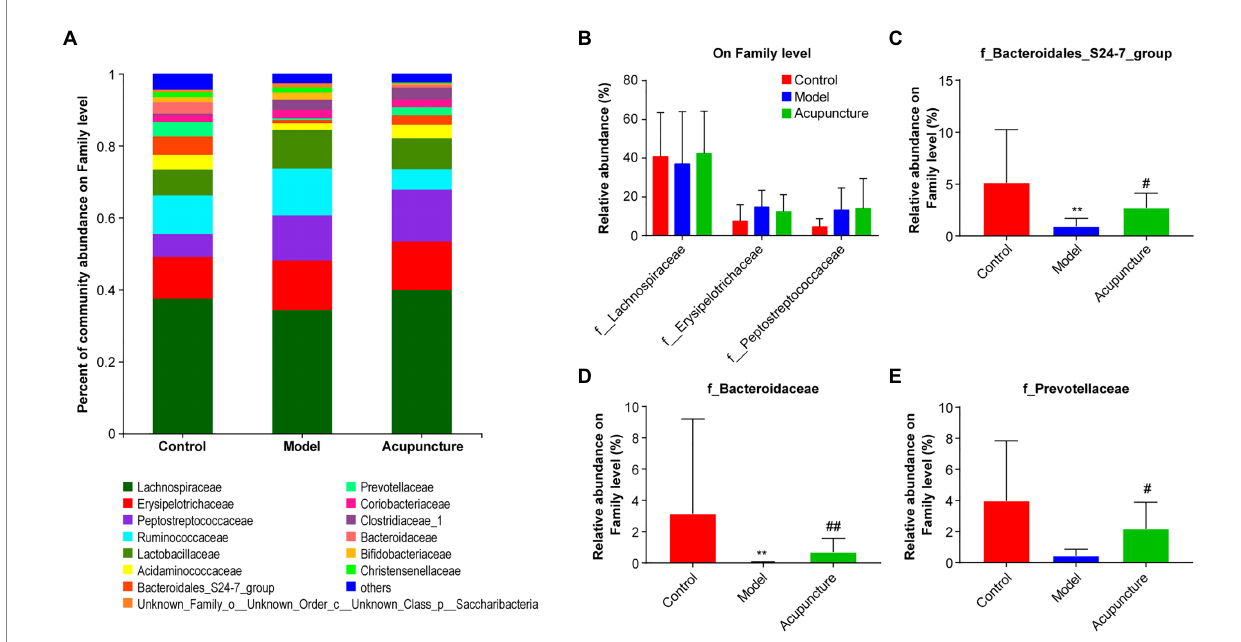
FIGURE 6 Impact of acupuncture on the composition of intestinal microbiota at the family level. (A) Community bar plot analysis. (B) Statistical difference analysis of the top three dominant microbiota families (Lachnospiraceae, Erysipelotrichaceae, and Peptostreptococcaceae) among all groups. (C) Bacteroidales_S24-7_group. (D) Bacteroidaceae. (E) Prevotellaceae. Data are shown as mean ± SD ( n = 8 per group). ** p < 0.01, Control vs. Model; # p < 0.05, ## p < 0.01, Model vs.